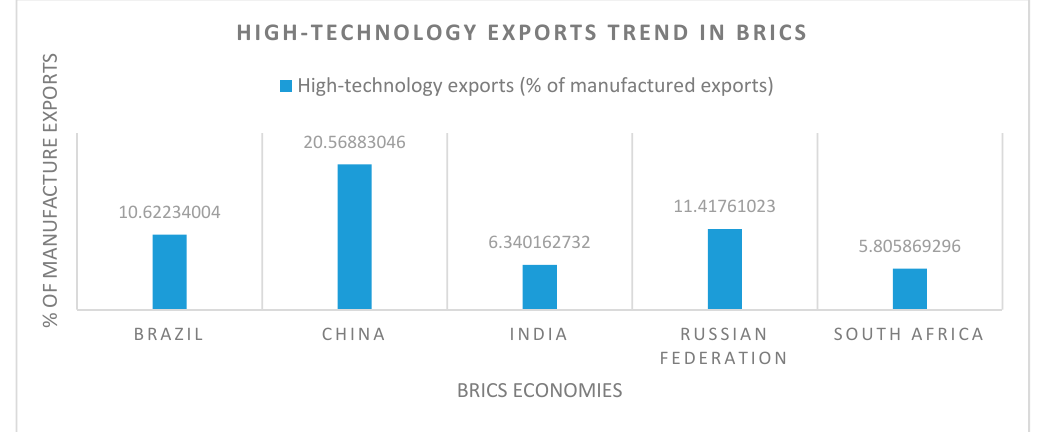
Figure 3. Technology adoption snapshot of BRICS: electric power consumption [27].